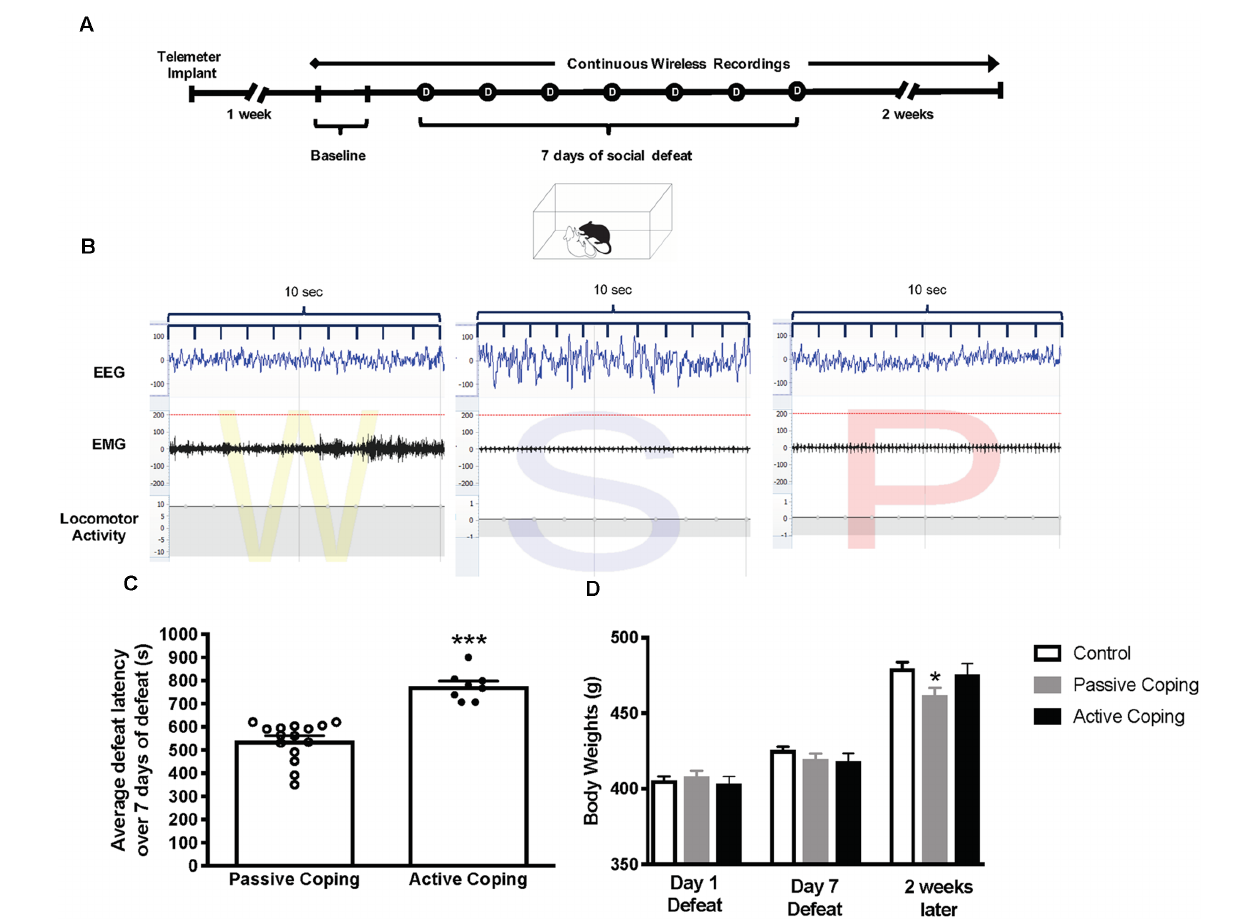
FIGURE 1 | Experimental paradigm, Average defeat latency, and body weights. (A) Experimental paradigm depicting the timeline for implantation of telemetry devices, continuous wireless Electroencephalogram (EEG)/Electromyogram (EMG) recordings, and 7-day social defeat exposure. (B) Representative EEG, EMG, and activity traces of Wake (denoted as W), slow-wave sleep (denoted as S) and rapid eye movement (REM) sleep (denoted as P for paradoxical sleep). (C) Average defeat latency over 7 days of social defeat. Passively coping rats ( n = 15) have a lower average defeat latency than actively coping rats ( n = 8; 540 ± 22 s vs. 776 ± 22 s, respectively). (D) Body weights for control ( n = 7), passively ( n = 15), and actively ( n = 8) coping rats on the first day of defeat, last day of defeat, and 2 weeks later. Groups do not differ in body weight on day 1 or day 7 of defeat, but passively coping rats weigh significantly less than control or actively coping rats 2 weeks after defeats have ended. * P < 0.05, *** P <